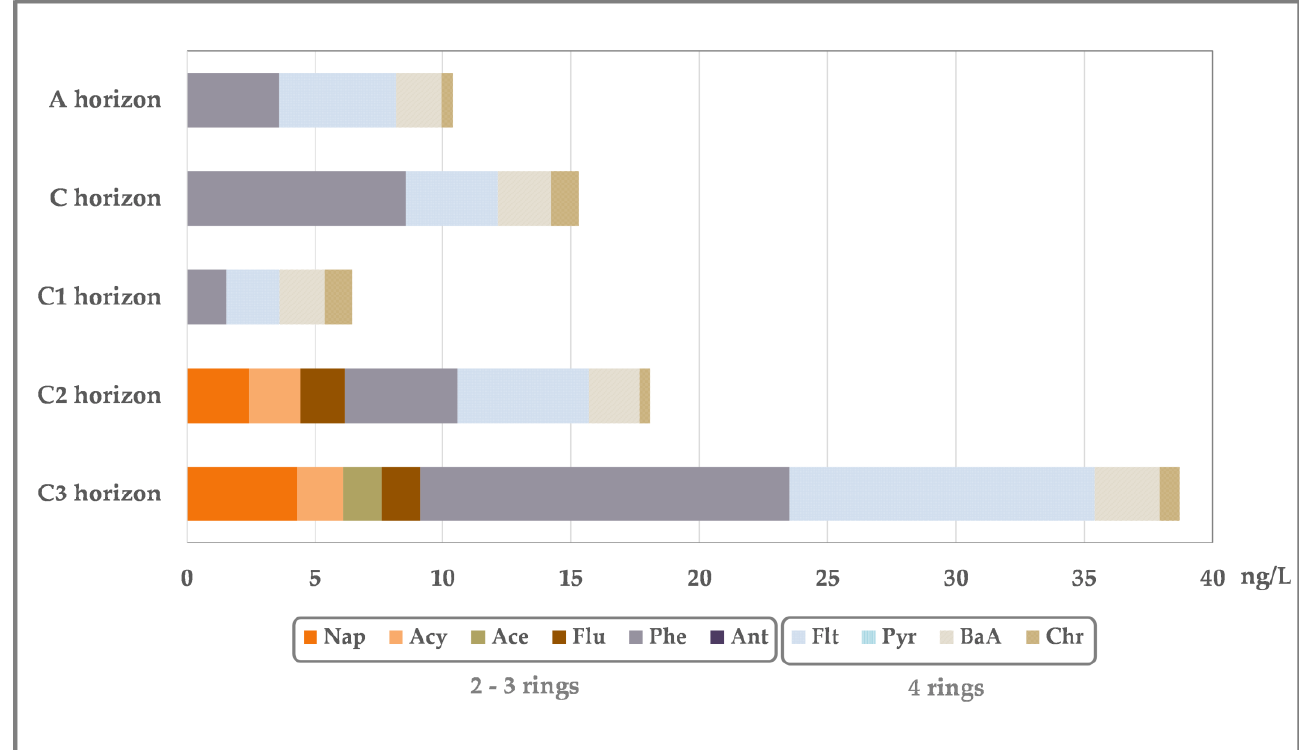
Figure 7. Concentration of PAHs in soil leachates from São Pedro da Cova mine waste pile .